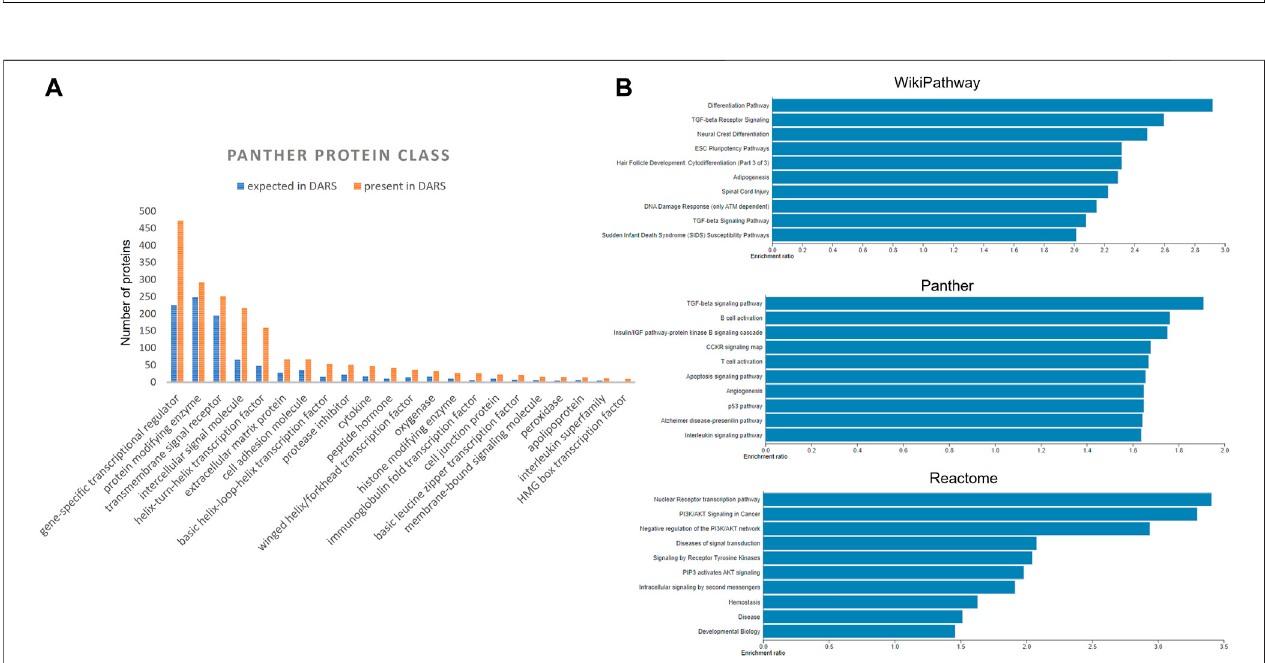
FIGURE6|(A) DistributionofDARSgenesacrossthePantherproteinclasses (B) Over-representedpathwaysinvolvingDARSgenesfromWikiPathways,Panther and Reactome, analysed using WebGestalt.